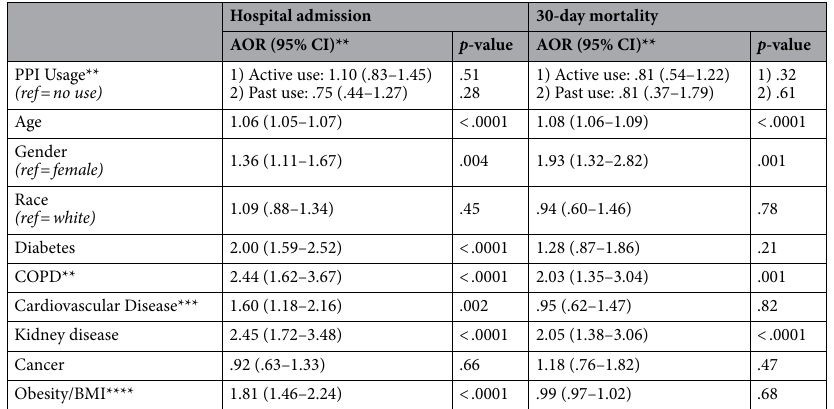
Table 3. Multivariable logistic regression for hospital admission within two weeks of COVID testing and 30-day mortality*. *Omnibus chi-square p -value < .0001; Hosmer–Lemeshow goodness-of-fit p-value = .51 (For Hospital Admission within Two Weeks of COVID Testing) and p-value = .49 (For 30-Day Mortality). ** AOR Adjusted odds ratio, CI Confidence interval, PPI Proton pump inhibitor, COPD Chronic obstructive pulmonary disease, BMI Body Mass Index. ***Cardiovascular disease is a composite of cardiomyopathy, congestive heart failure, and coronary artery disease. ****Obesity utilized for a Hospital Admission within 2 Weeks of COVID Testing) and BMI utilized for 30-Day Morality; Defined as BMI > 30